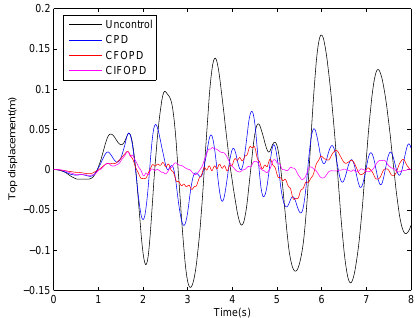
Figure 5. Top displacement curve under centralized control.